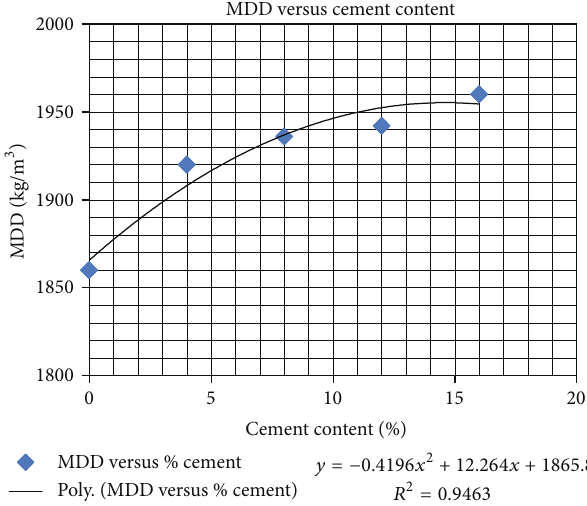
Figure 5: Relationship between maximum dry density and cement content for stabilized